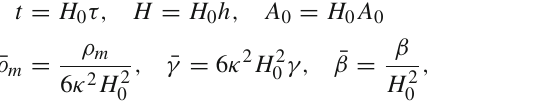
(dotted)oftheparameters α and ¯ β asgiveninTable1.Thesolidlinecor- responds to the (cid:2) CDM model, and the error bars are the observational data with their